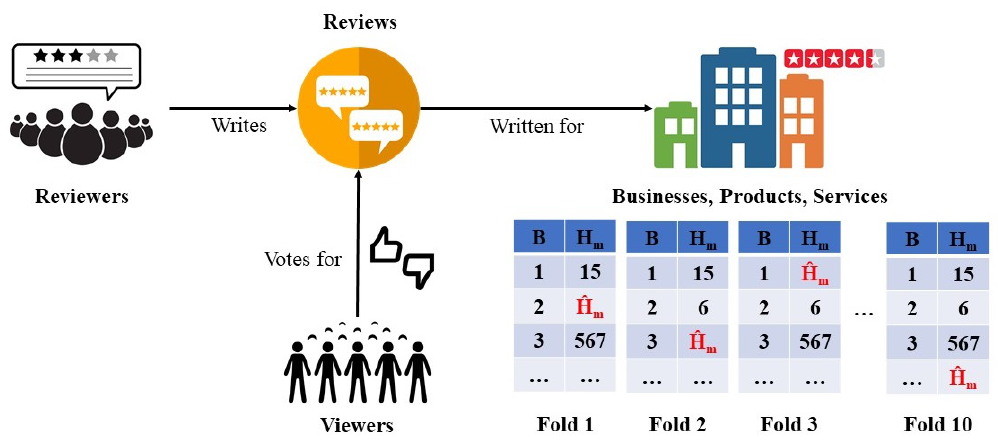
Figure 4. An overview of cumulative helpfulness prediction. Algorithm 1: Feature Generation